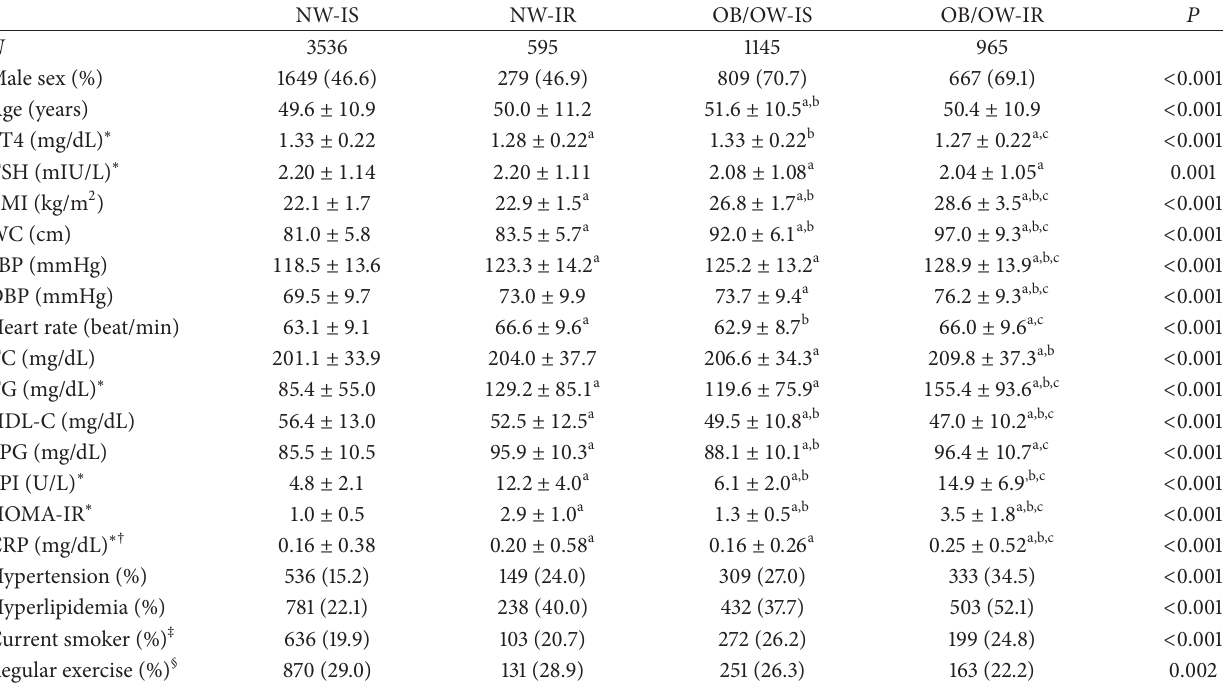
Table 1: Clinical characteristics of the 6241 subjects.